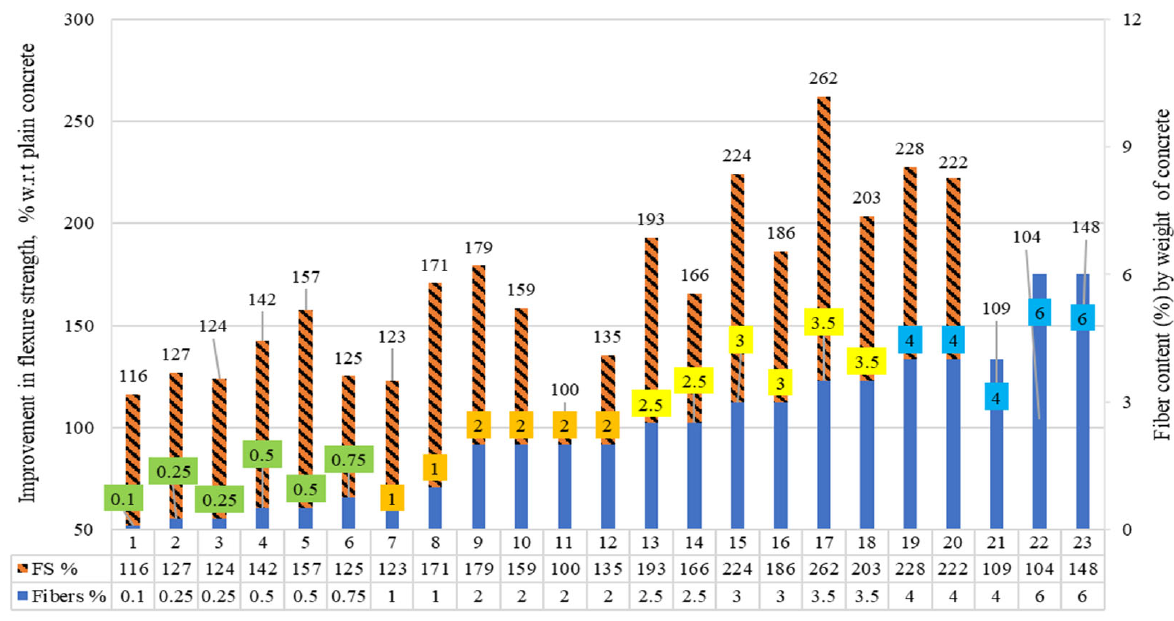
Figure 14. Percentage comparison of flexure strength of concrete containing RSF by weight.